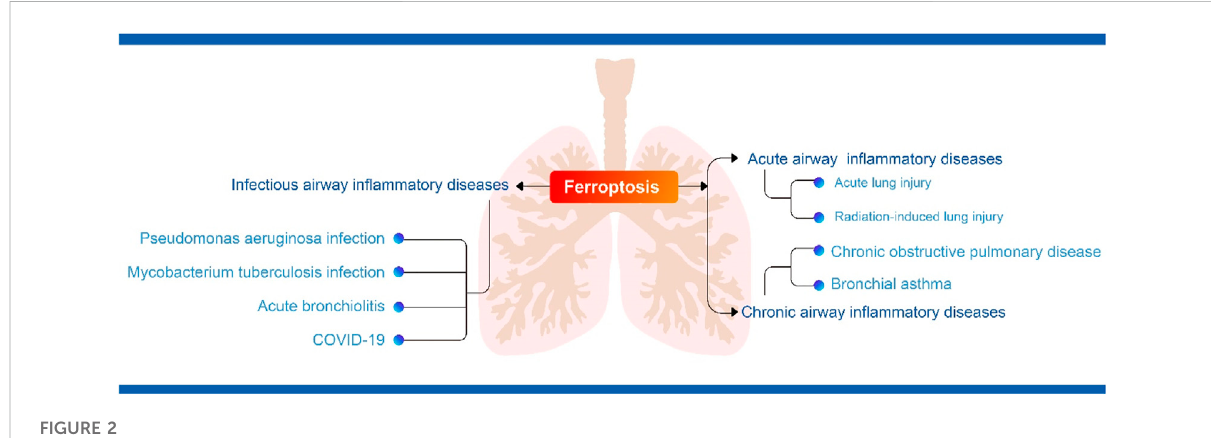
FIGURE 2 (The relationship between ferroptosis and airway in fl ammatory